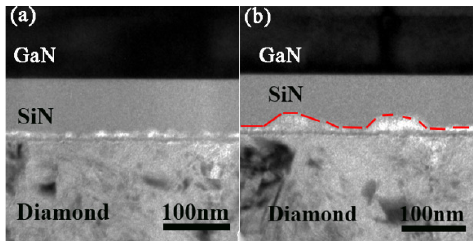
Figure 3. TEM micrographs of GaN-on-diamond interfaces grown with different structure interlayers of ( a ) SiN x (orig) and ( b ) SiN x (peri).